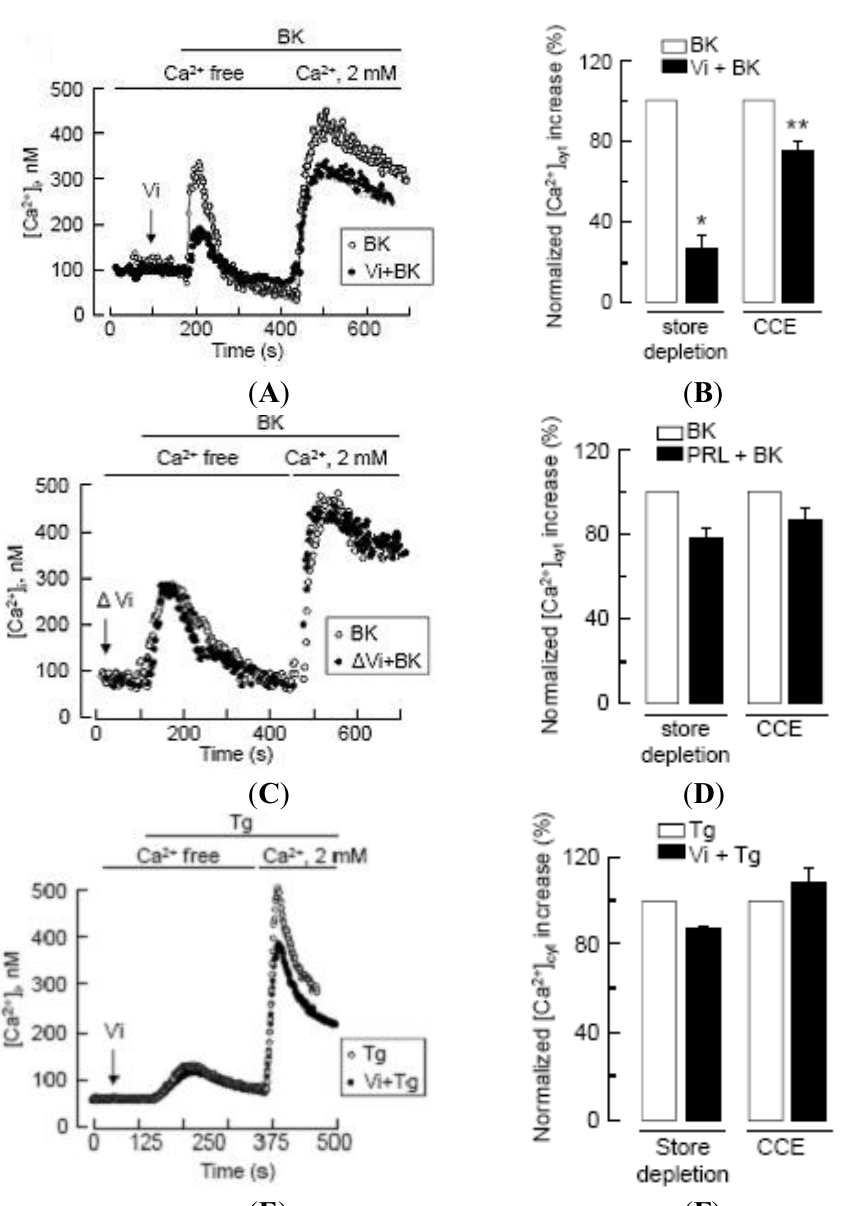
Figure 3. Vasoinhibins reduce both Ca 2+ store depletion and capacitative Ca 2+ entry (CCE) stimulated by BK in